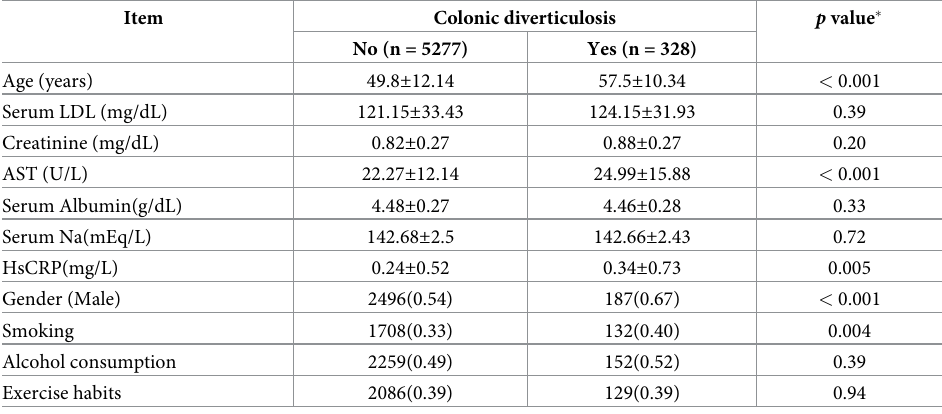
Table 1. The description statistics of study